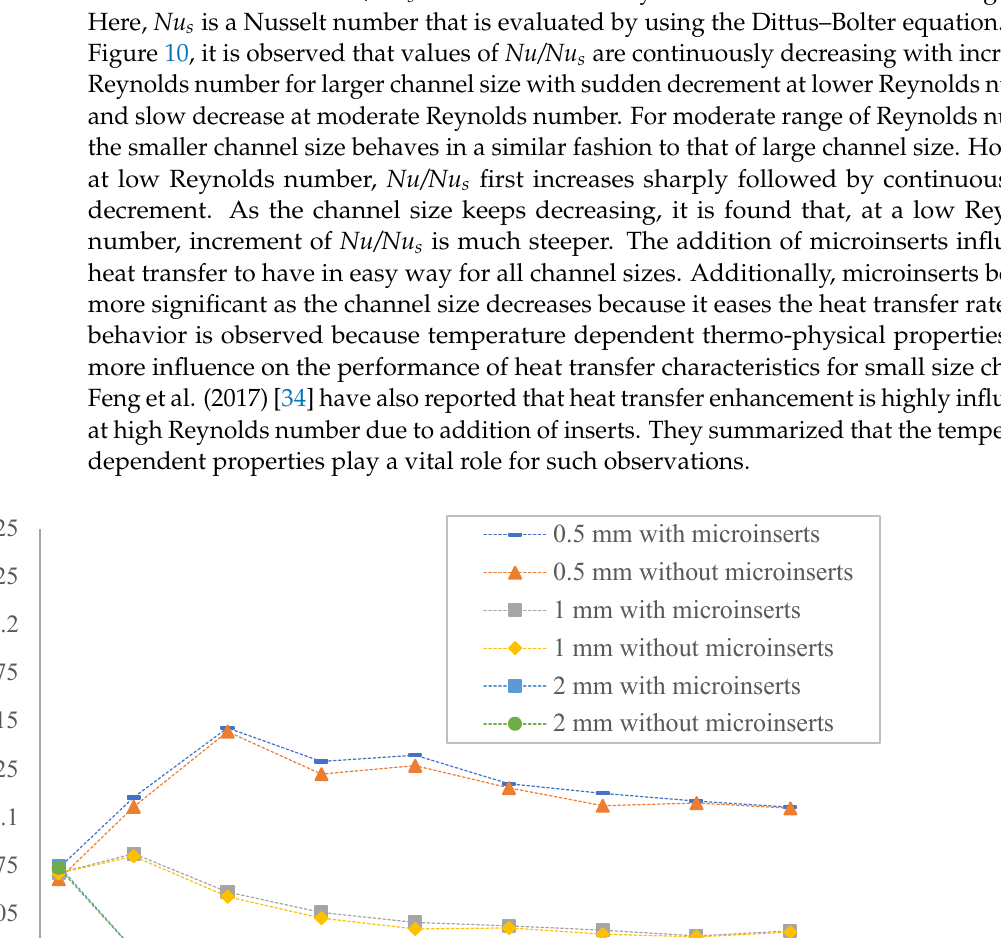
Figure 10. Variation of Nu/Nu s with Reynolds number.